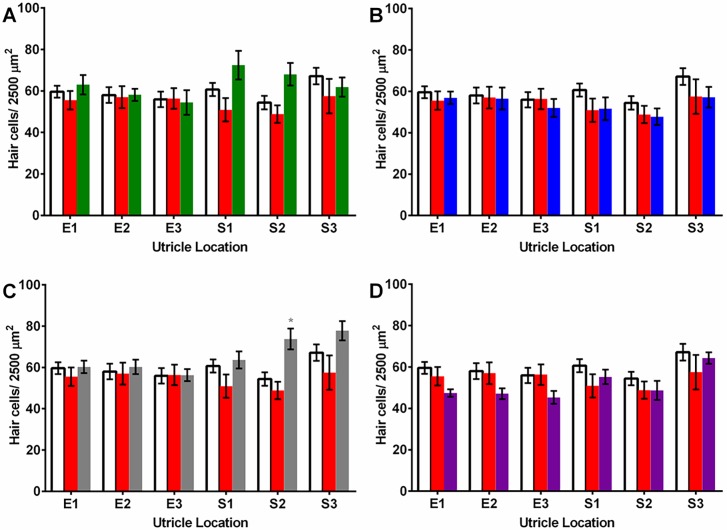
Mean (±SE) hair cell densities in six regions of the utricle treated with either a monofunctional platinum(II) complex, cisplatin or vehicle after 48 hours.A.-D. Cisplatin (red) treatment; vehicle (white) treatment; E1-E3: extrastriolar regions; S1-S3: striolar regions. A. Pyriplatin (green) treatment. B. Phenanthriplatin (blue) treatment. C. [Pt(dien)Cl]+ (grey) treatment had one elevated mean hair cell density count at S2. D. [Pt(Et2dien)Cl]+ (purple) treatment. N = 8–15.